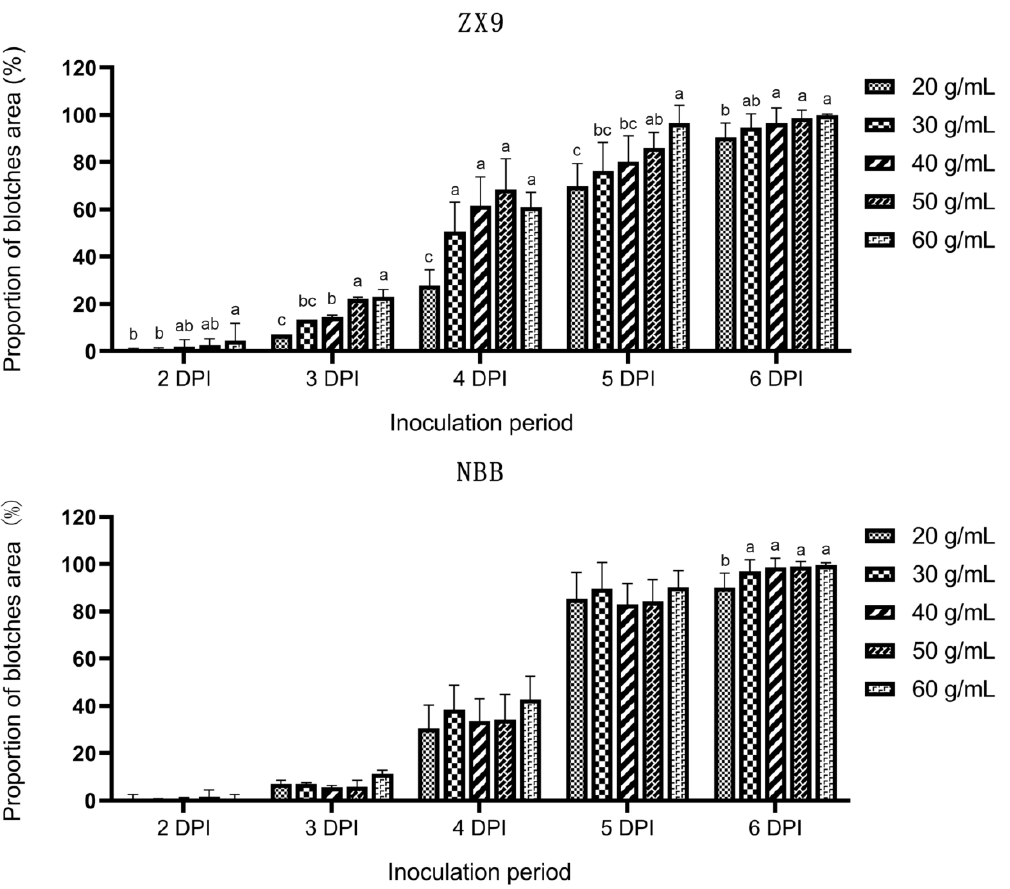
Figure 1. Proportion of the pod surface area covered with blotches 2 to 6 days after inoculation of the pods of Zhexian No. 9 (ZX9) and Nanhua Black Bean (NBB) soybean, with different concentrations of mycelial suspensions. The different letters above the columns indicate significant differences ( p = 0.05) determined by two-tailed t